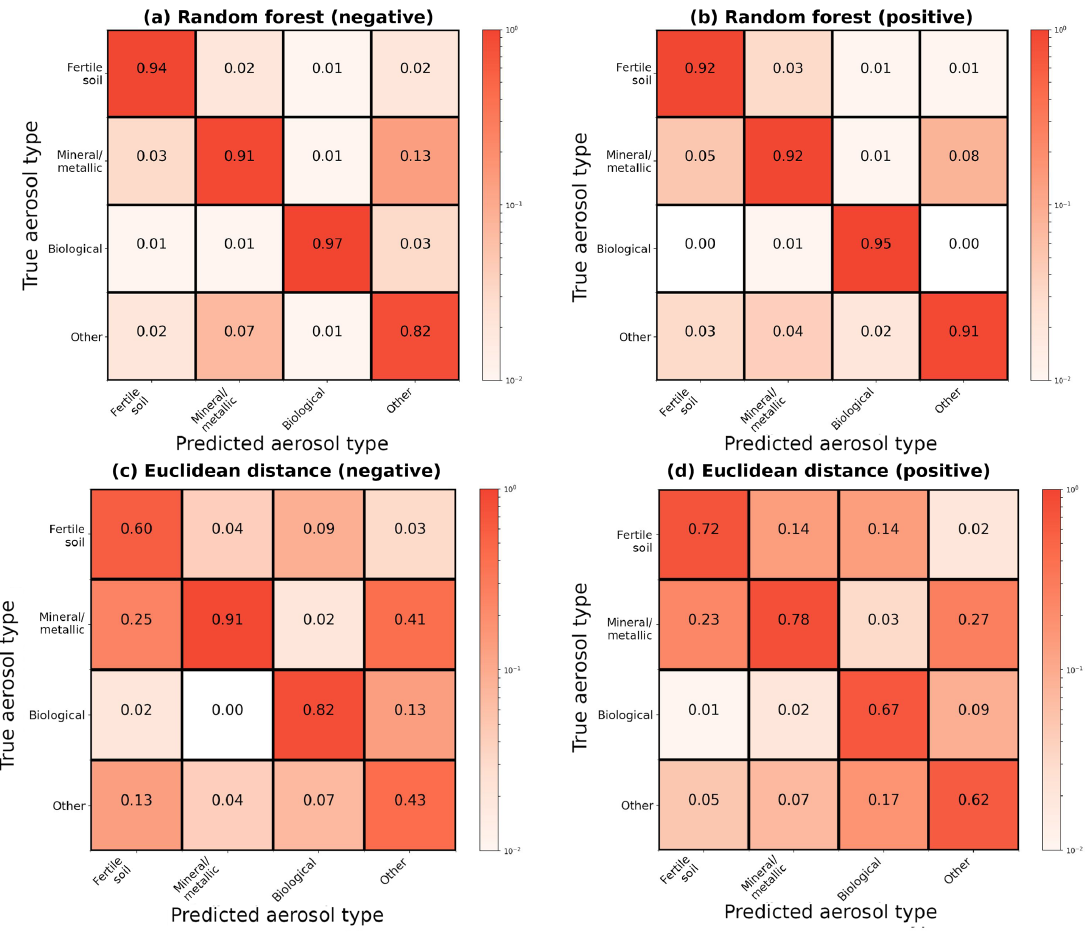
Figure 4. Column-normalized confusion matrices for the broad categorization of aerosols following the convention in Fig. 3. (a, b) For all aerosol categories, the random forest has an accuracy of 93% in positive ion mode and 91% in negative ion mode. (c, d) The Euclidean distance classifier has an accuracy of 70% in positive ion mode and 69% in negative ion mode.